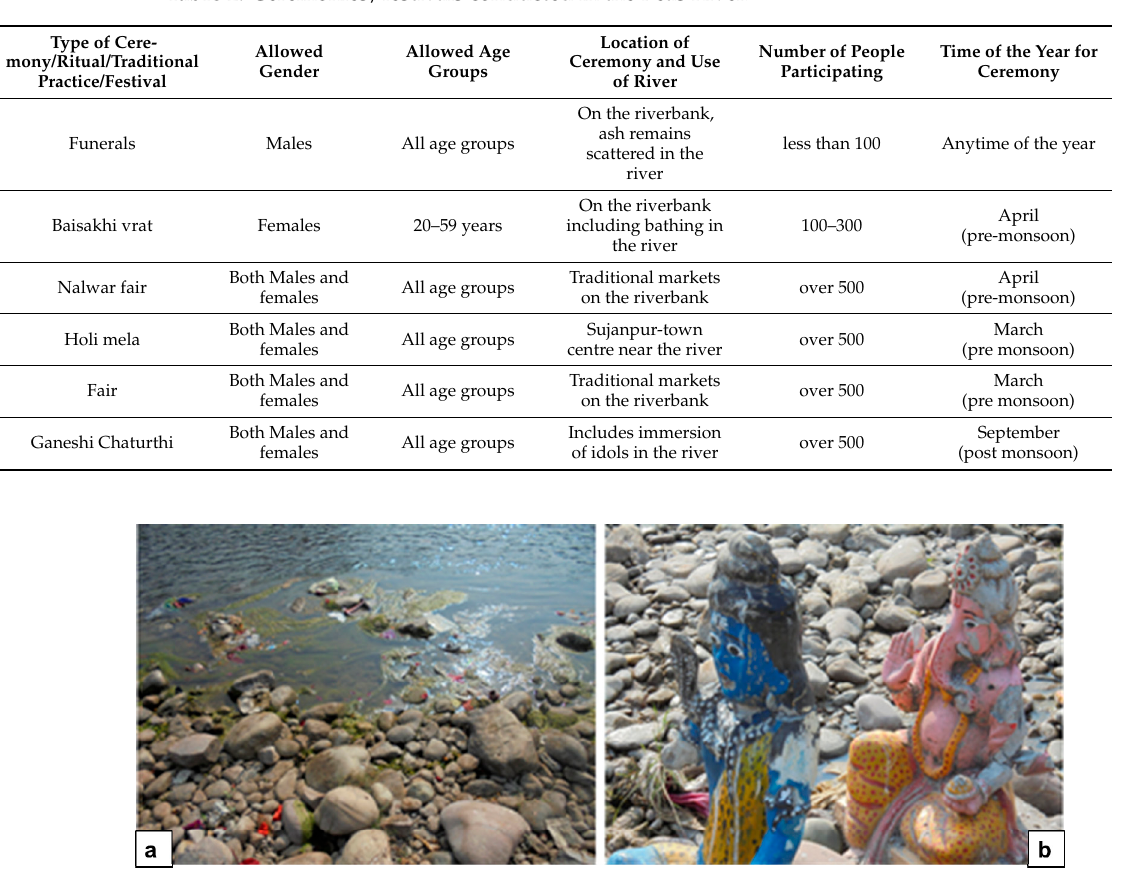
Figure 5. Some of the materials immersed in the Beas River during cultural rituals/ceremonies. ( a ) floating red material remnants and ( b ) statues/idols in the riverbed (source: lead author, 2017). Most ceremonies are undertaken during the pre-monsoon period except funerals which are done anytime of the year and a post-monsoon festival in Nadaun (Table 2). Findings also show that most ceremonies are attended by both males and females of all age groups except one female-only festival in Sujanpur and funerals which are only attended by